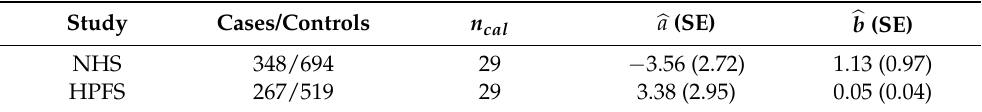
Table 4. Number of cases and controls, size of the calibration study ( n cal ), and the estimated intercept and slope of the calibration model for each study in the pooled analysis.